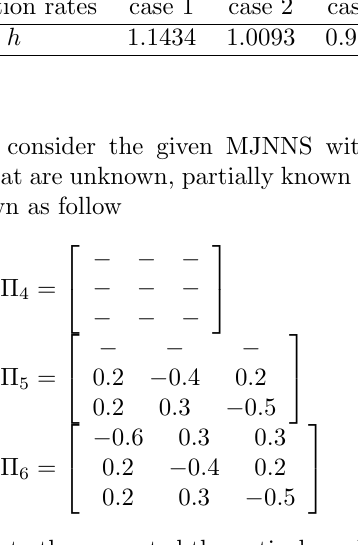
Table 1: The maximum stable delay of the MJNNS with different transition rates transition rates